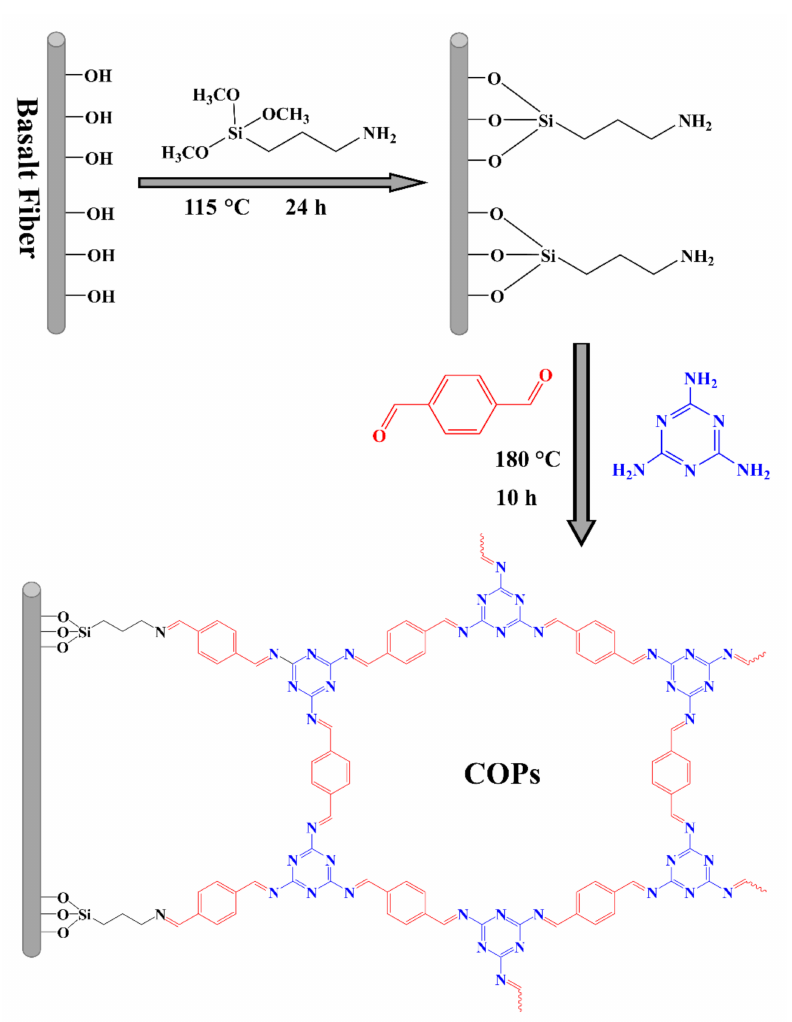
Figure 1. Schematic diagram of chemical reaction for in-situ generation of covalent organic porous polymers (COPs) on the surface of basalt fibers.